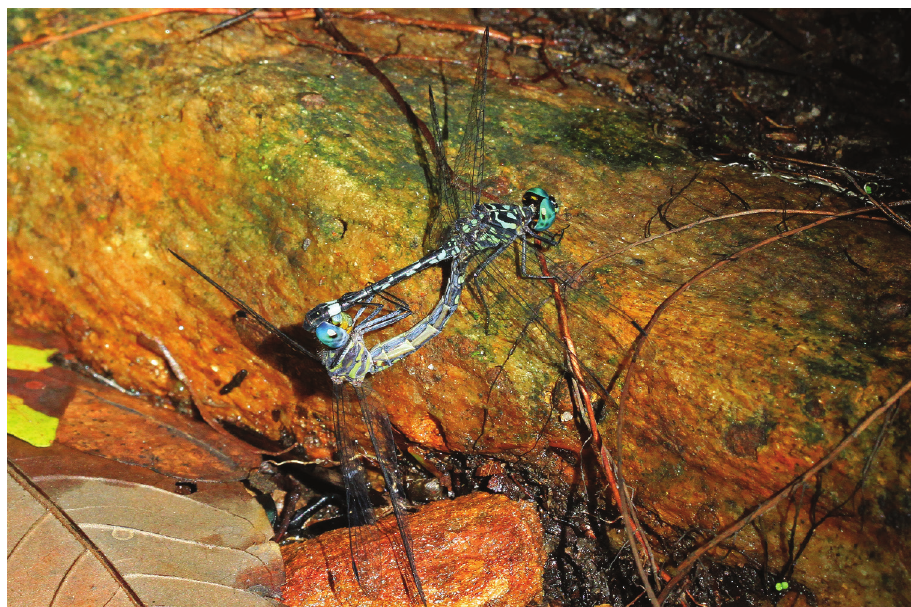
Figure 9. Notiothemis jonesi , copulation within the male territory in the bed of the Mikwa Stream near Chingombe, Zambia (phot. B.